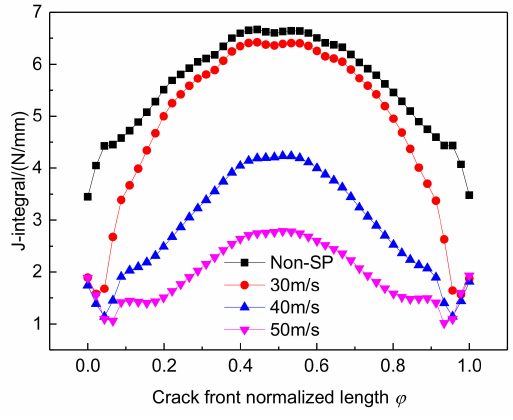
Figure 8. J-integral of crack fronts at different shot velocities.